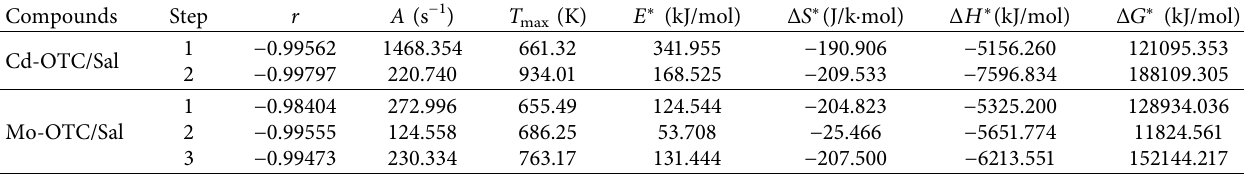
Table 1: Kinetic and thermodynamic parameters of the complexes.